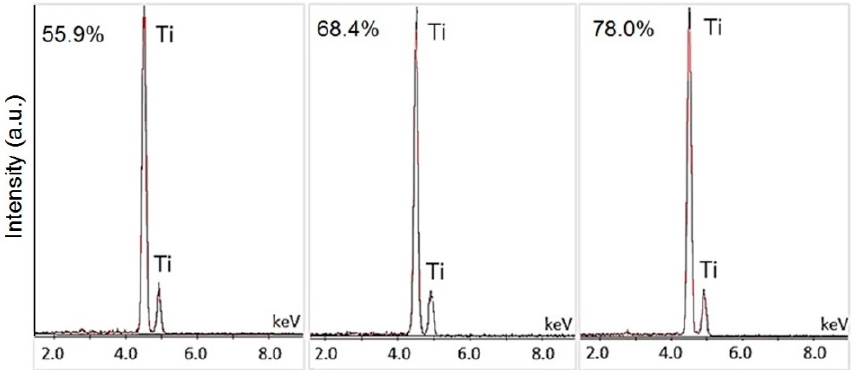
Figure 6. EDS analysis of manufactured foam samples with three different porosity contents (55.9%, 68.4%, and 78.0%).